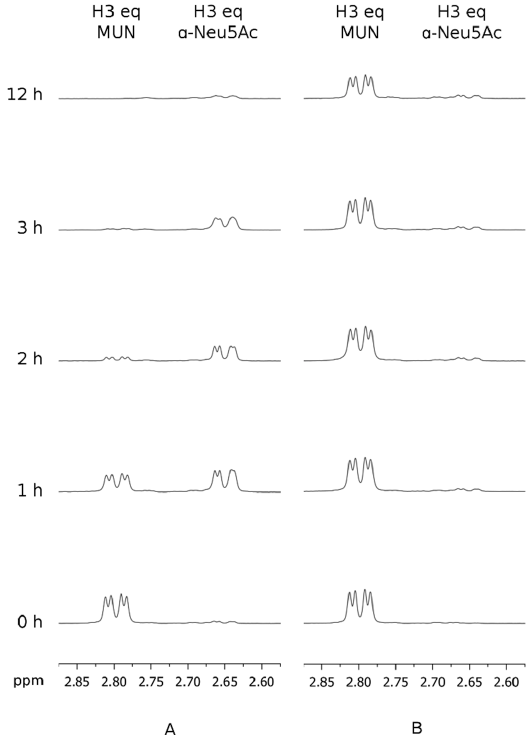
Figure 2. Time course study of the blockade of human parainfluenza virus-1 haemagglutinin-neuraminidase (hPIV-1 HN) neuraminidase activity by compounds 2 and 3. The hydrolysis of 4-methylumbelliferyl α - d - N -acetylneuraminide (MUN) by hPIV-1 HN, pre-incubated with either compound 2 or 3 (50 µ M), was monitored by 1 H NMR spectroscopy over 12 h at 37 ◦ C. ( A